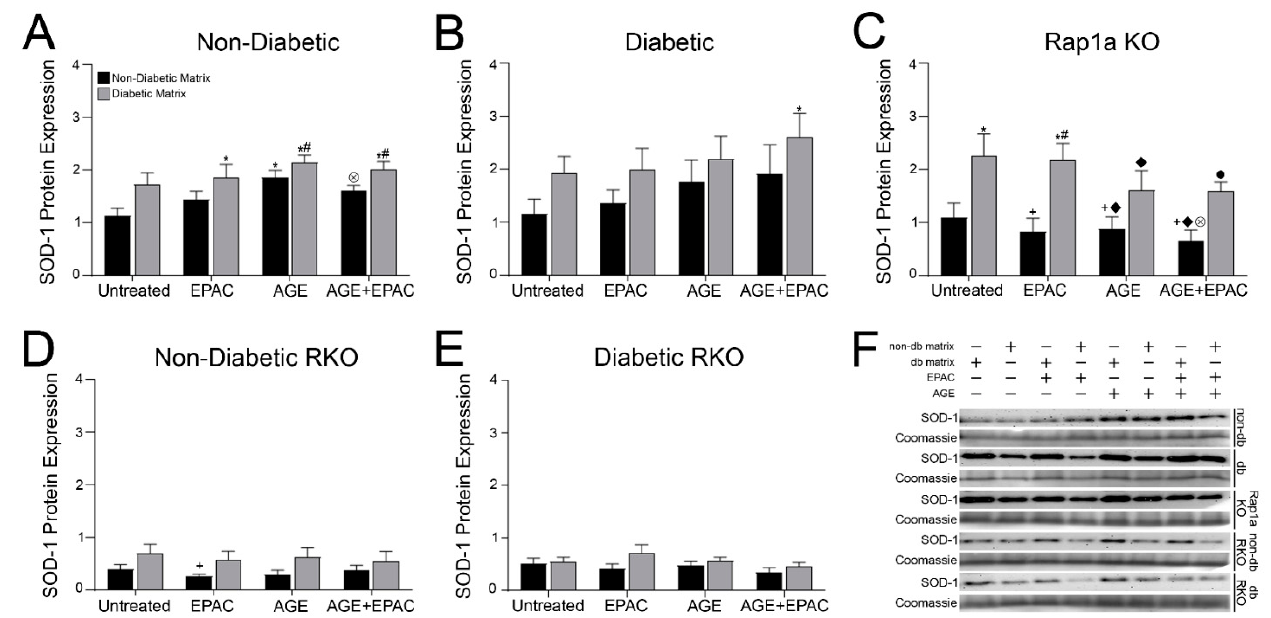
Figure 5. AGEs within diabetic collagen induced changes in SOD-1 expression utilizing both the AGE/RAGE signaling cascade and Rap1a. Cardiac fibroblasts from ( A ) non-diabetic, ( B ) diabetic, ( C ) Rap1a KO, ( D ) non-diabetic RKO, and ( E ) diabetic RKO were embedded in non-diabetic (black bars) and diabetic (grey bars) matrices. Protein expression was assessed by Western blot analysis for SOD-1 (23 kDa) and normalized to total protein (Brilliant Blue Coomassie Stain) in untreated, EPAC (100 μ M), exogenous AGEs (0.05 mg/mL), and EPAC+exogenous AGEs (100 μ M and 0.05 mg/mL, respectively) cardiac fibroblasts. ( F ) Representative Western blot images for SOD-1 protein expression and non-db = non-diabetic matrix and db matrix = diabetic matrix. Data are means ± SEM with n = 5–10. Statistical analysis consisted of a two-way ANOVA followed by a Fisher’s Least Significant Difference post hoc. Symbols above each bar indicate significance between a specific group ( p < 0.05; * vs. untreated in non-db, + vs. untreated in db, # vs. EPAC in non-db, (cid:117) vs. EPAC in db, ⊗ vs. AGE in db, and vs. AGE+EPAC in non-db). Untreated treatment groups presented were initially presented in Figure 3C.